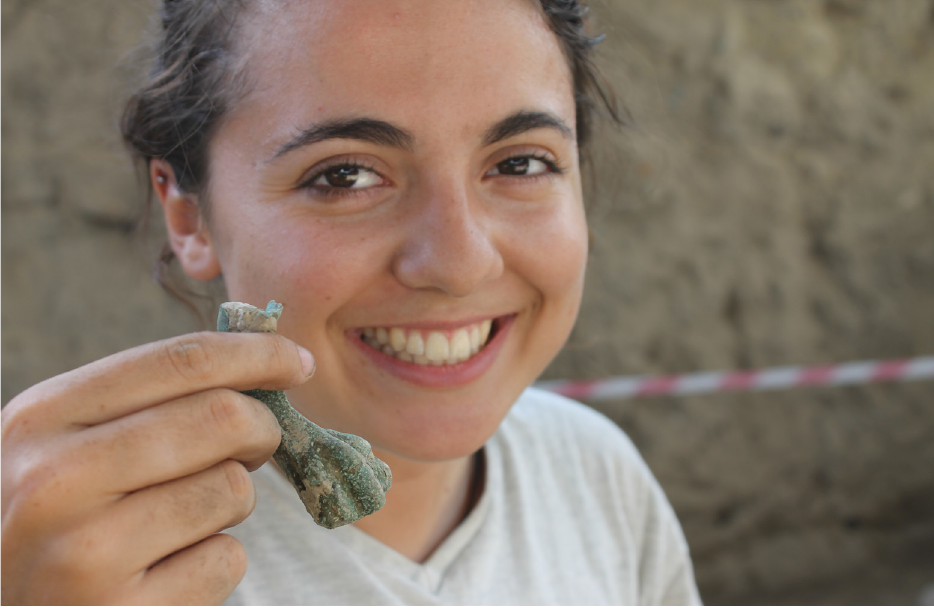
Fig. 11: A notable find at Taraz was a copper-alloy animal paw, from one of the numerous refuse